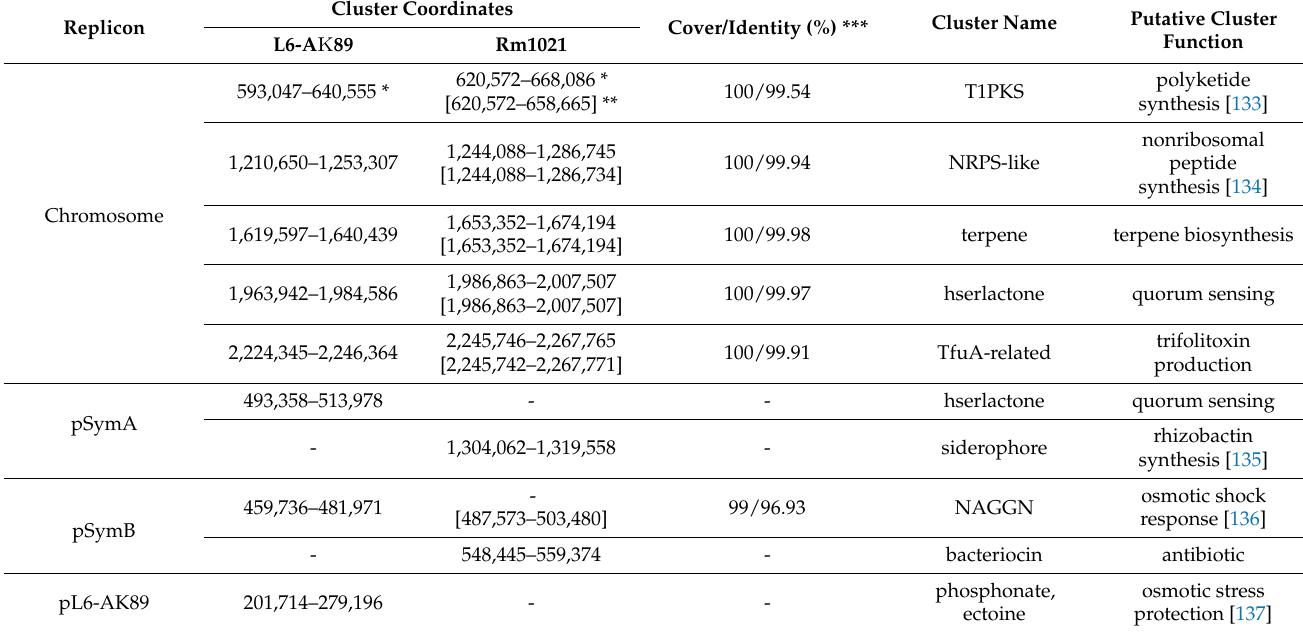
Table 3. Biosynthetic gene clusters in L6-AK89 and Rm1021